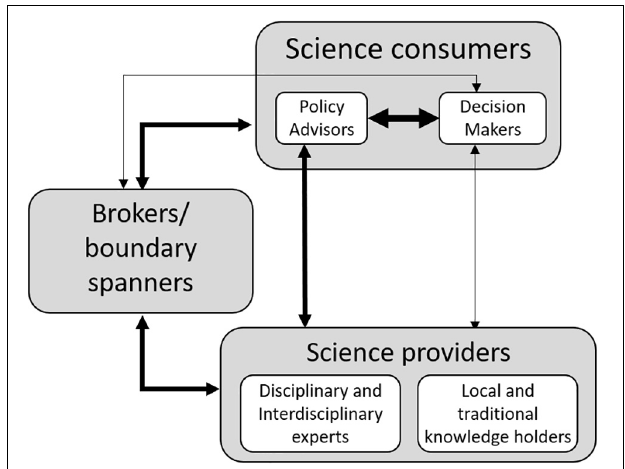
FIGURE 1 | Roles and interrelations among actors involved in science-policy arenas (arrow thickness suggests relative strengths of the relationship between